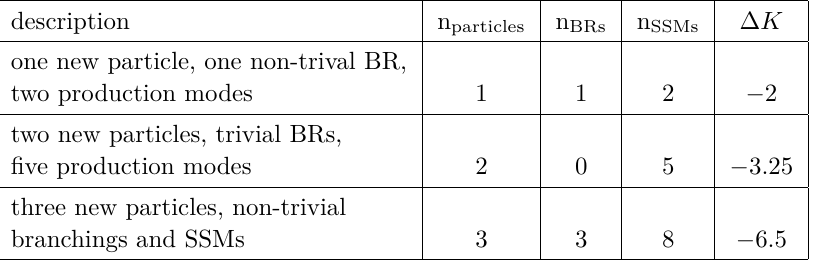
Table 2 . Examples of proto-model parameters and how the corresponding prior affects the proto- model test statistic. The last column displays the decrease in the test statistic: ∆ K = 2 ln π ( BSM )